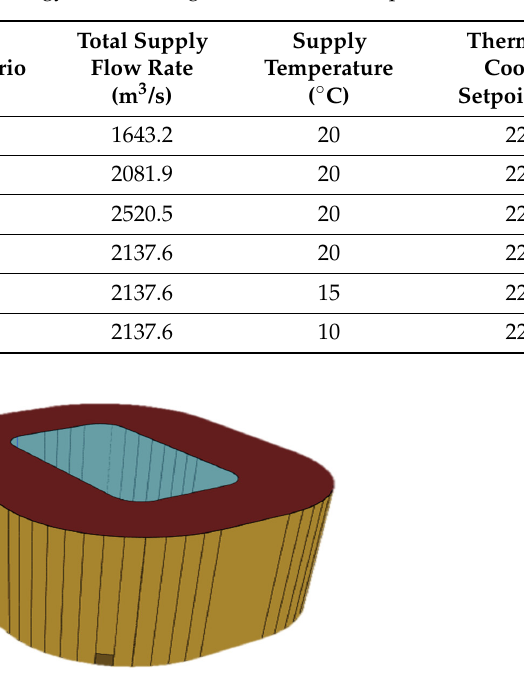
Table 4. EnergyPlus building and HVAC model parameter settings.